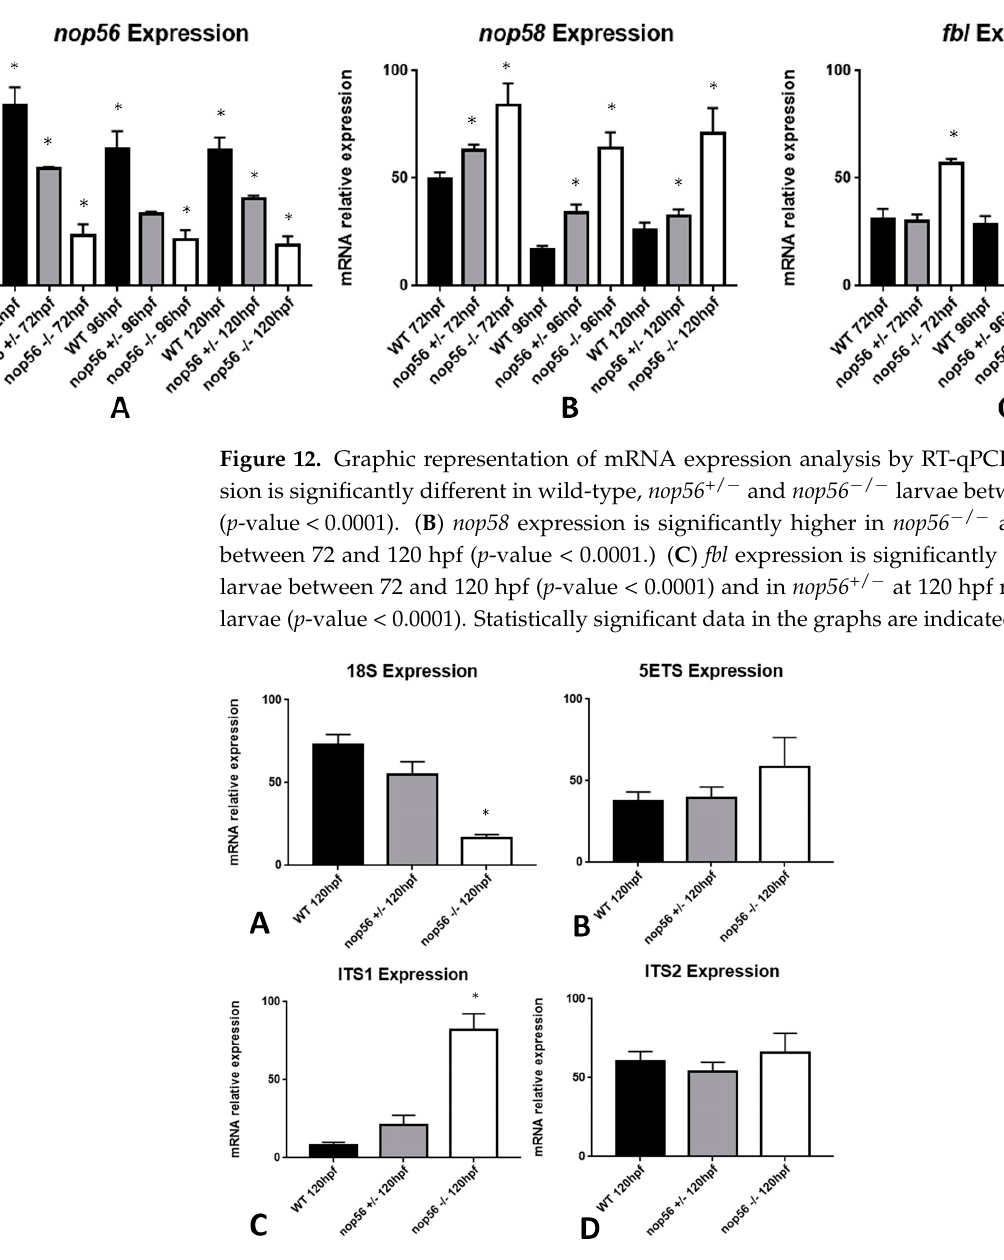
Figure 13. Graphic representation of expression analysis by RT-qPCR. ( A ) 18S rRNA expression is significantly reduced in nop56 − / − larvae at 120 hpf ( p -value < 0.0001). ( B ) 5ETS expression does not differ between wild type, nop56 − / − and nop56 +/ − embryos at 120 hpf ( C ) ITS1 expression is significantly higher in nop56 − / − larvae between at 120 hpf ( p -value < 0.0001). ( D ) ITS2 expression does not differ between wild type, nop56 − / − and nop56 +/ − larvae at 120 hpf. Statistically significant data in the graphs are indicated with a *.